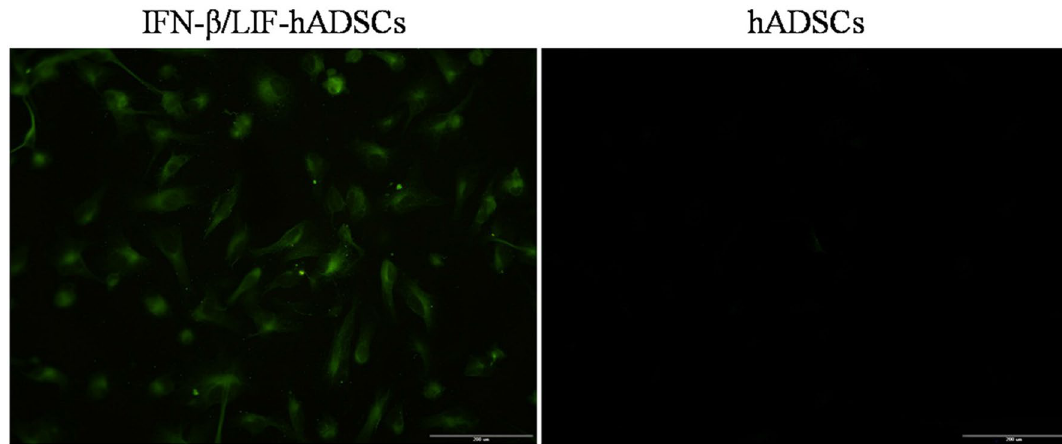
Figure 1. Fluorescence microscope examination of overexpressed IFN-β and LIF in hADSCs that co-express GFP from the LV/IFN-β/LIF/GFP IFN‑β/LIF‑hADSCs improved the clinical score of EAE mice. To investigate the effect of un-trans- duced and transduced hADSCs in the treatment of EAE mice, an intravenous injection of 10 6 cells was per- formed at the onset of the inflammatory phase of the disease (on day 12 DPI) when the first symptoms (loss of tail tonicity) were seen. Up to 32 DPI, Mice clinical scores were recorded. Overall, the clinical score decreased in the three treatment groups compared to the untreated EAE group. Maximum clinical scores (mean ± SEM) for PBS, GFP, hADSCs, and IFN-β/LIF-hADSCs groups were 3.8 ± 0.69, 1.4 ± 0.15, 1.4 ± 0.08, and 1.2 ± 0.10, respectively, which in IFN-β/LIF-hADSCs group was significantly lower than the other three treatment groups ( P < 0.001). On the last day after immunization (32DPI), the clinical score means of treated mice decreased sig- nificantly compared with untreated EAE (PBS), ( P < 0.001) (Fig. 3). IFN‑β/LIF‑hADSCs limited the weight loss in the EAE mice. Two days after MOG vaccination, a weight loss was observed in all mice, our information within 32 days showed that the body weight in treatment groups was significantly higher than the PBS group. Meanwhile, the body weight means in the PBS group was significantly decreased (DPI32). The mean weight of mice in Control (20.39 ± 0.19), PBS (17.30 ± 1.16), IFN-β/LIF-hADSCs (17.30 ± 0.27), GFP (18.34 ± 0.38) and hADSCs (17.30 ± 0.58) groups had not significantly changed in DPI12. In DPI32, the mean weight of Control (22.18 ± 0.19), PBS (15.69 ± 1.18), IFN-β/LIF-hADSCs (20.08 ± 0.18), GFP (21.81 ± 0.17), and hADSCs (20.08 ± 0.02) groups indicated a signifi- cant improvement in body weight in the three treatment groups. Generally, there was no significant difference